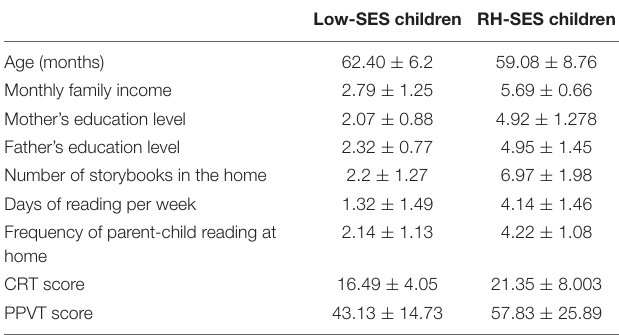
TABLE 2 | Demographic characteristics of participants.